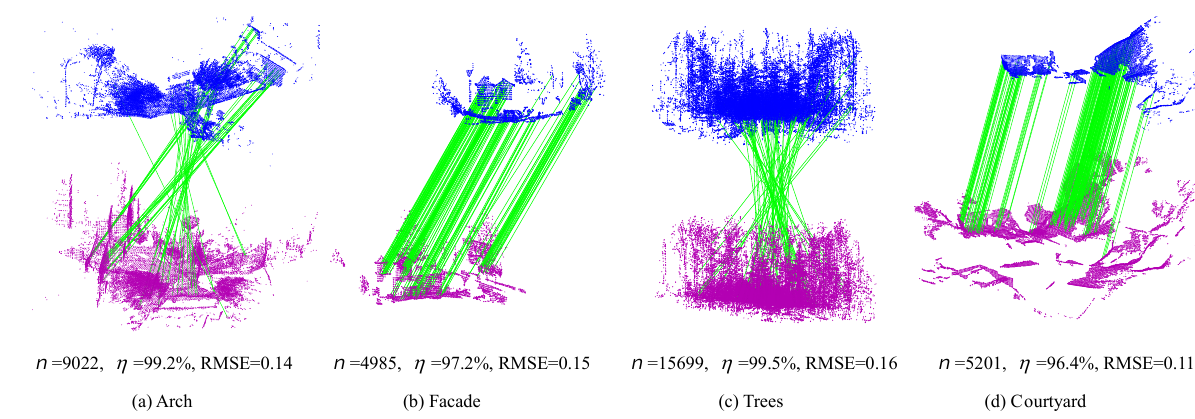
Figure 10. Our 3D matching results on four LIDAR scan pairs. n is the number of initial 3D correspondences and η is the outlier rate of initial correspondences. Each line represents a 3D